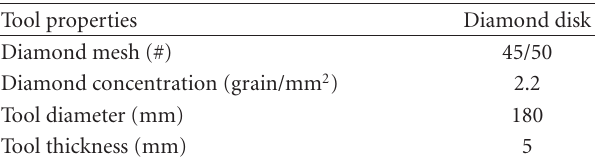
Table 1: Tool properties.